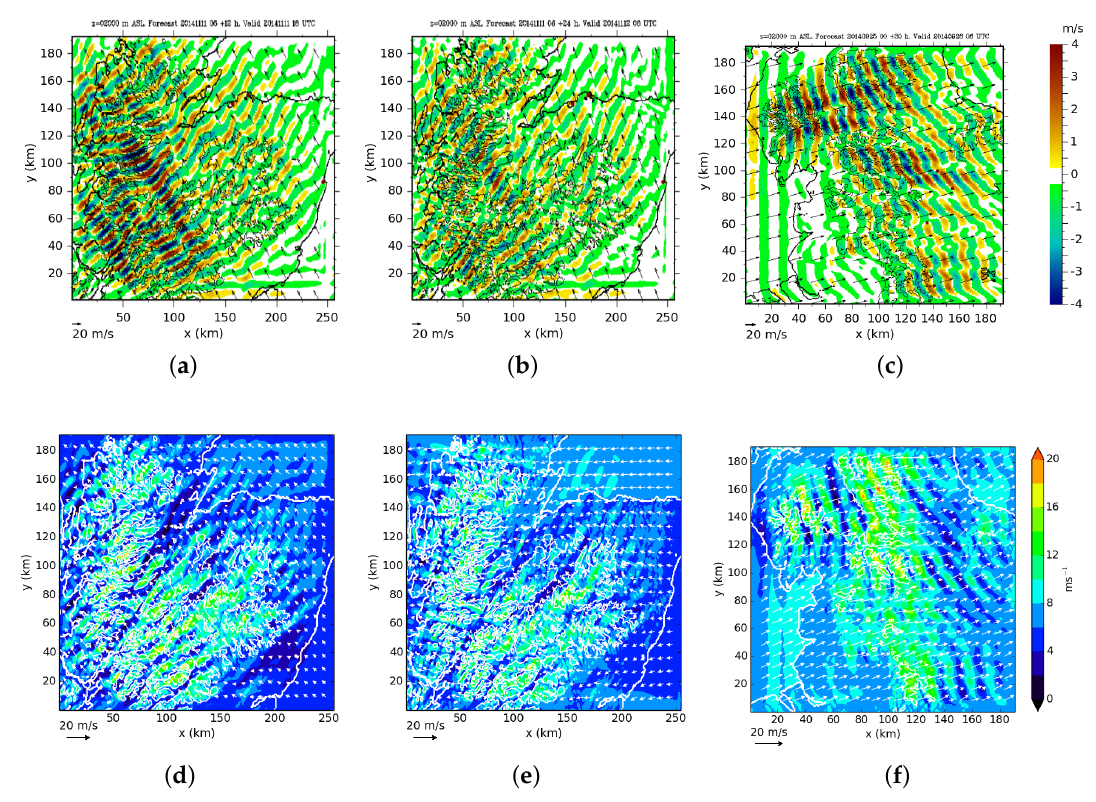
Figure 4. As Figure 2, but for the Grampians domain at ( Left ) 18Z 11 November 2014, ( Center ) 06Z 12 November 2014 and ( Right ) the Pennines domain at 06Z 25 September